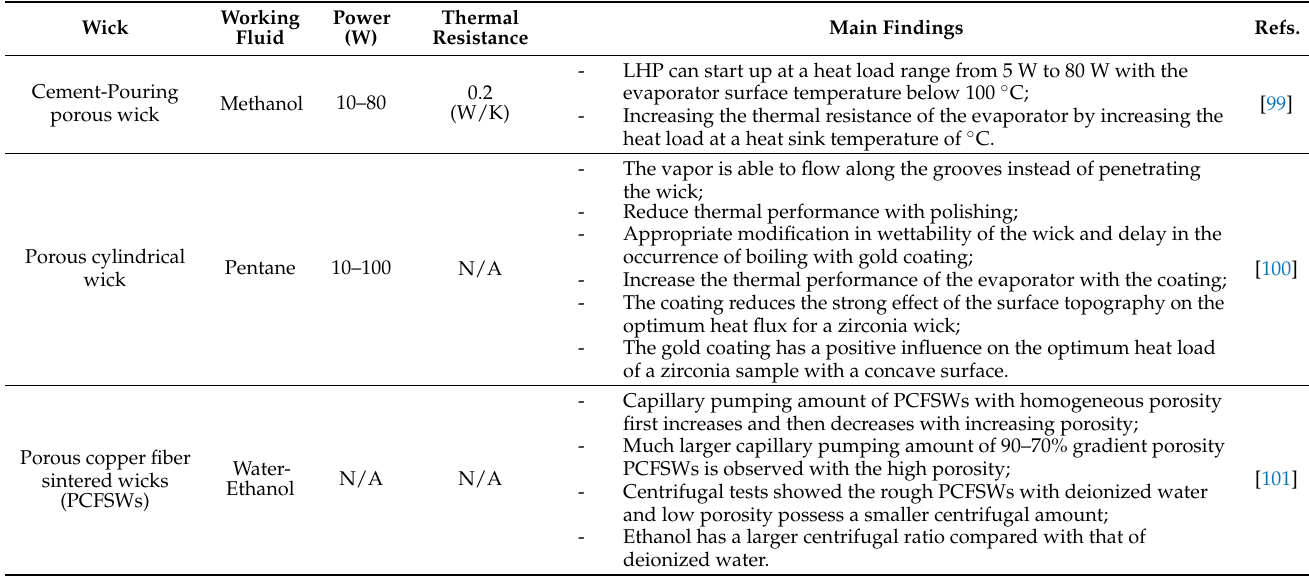
Table 2. The comparison between different attempts to increase LHP performance by using wick structures.